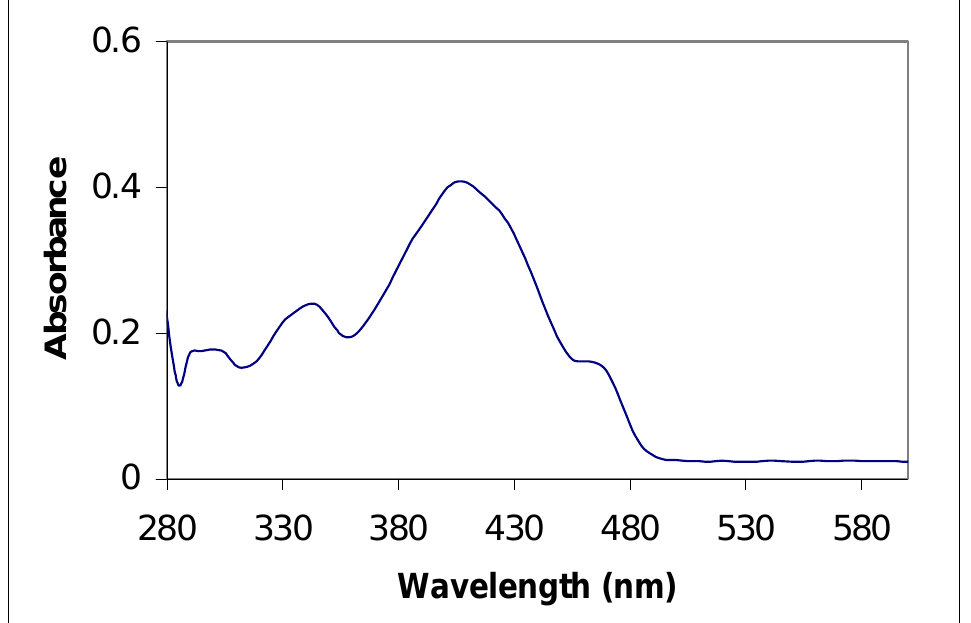
Figure 4. UV-Visible spectra of compound 8b in